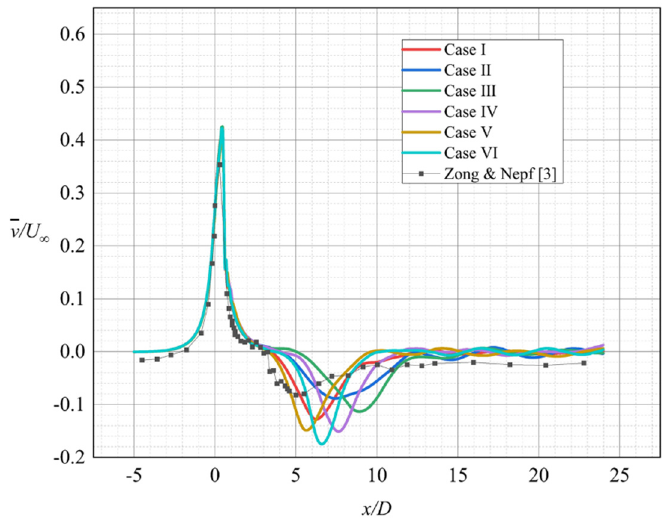
Figure 7. Transverse velocity v is measured at line y = D /2; the black dot plot in the figure is the experimental data of Zong and Nepf ( Φ = 0.1, D = 22 cm)